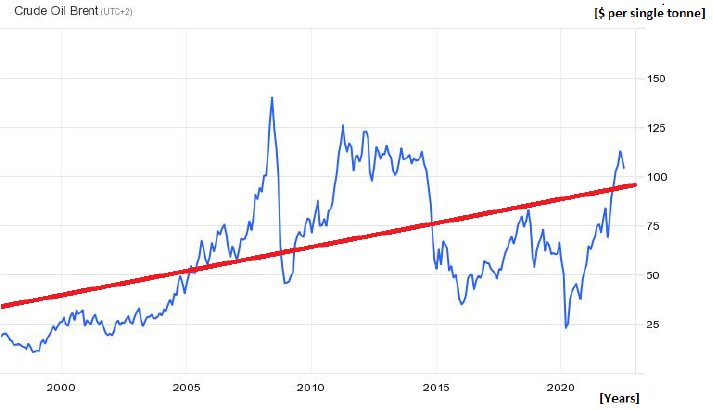
Figure 12. Crude oil Brent price from 1997 to